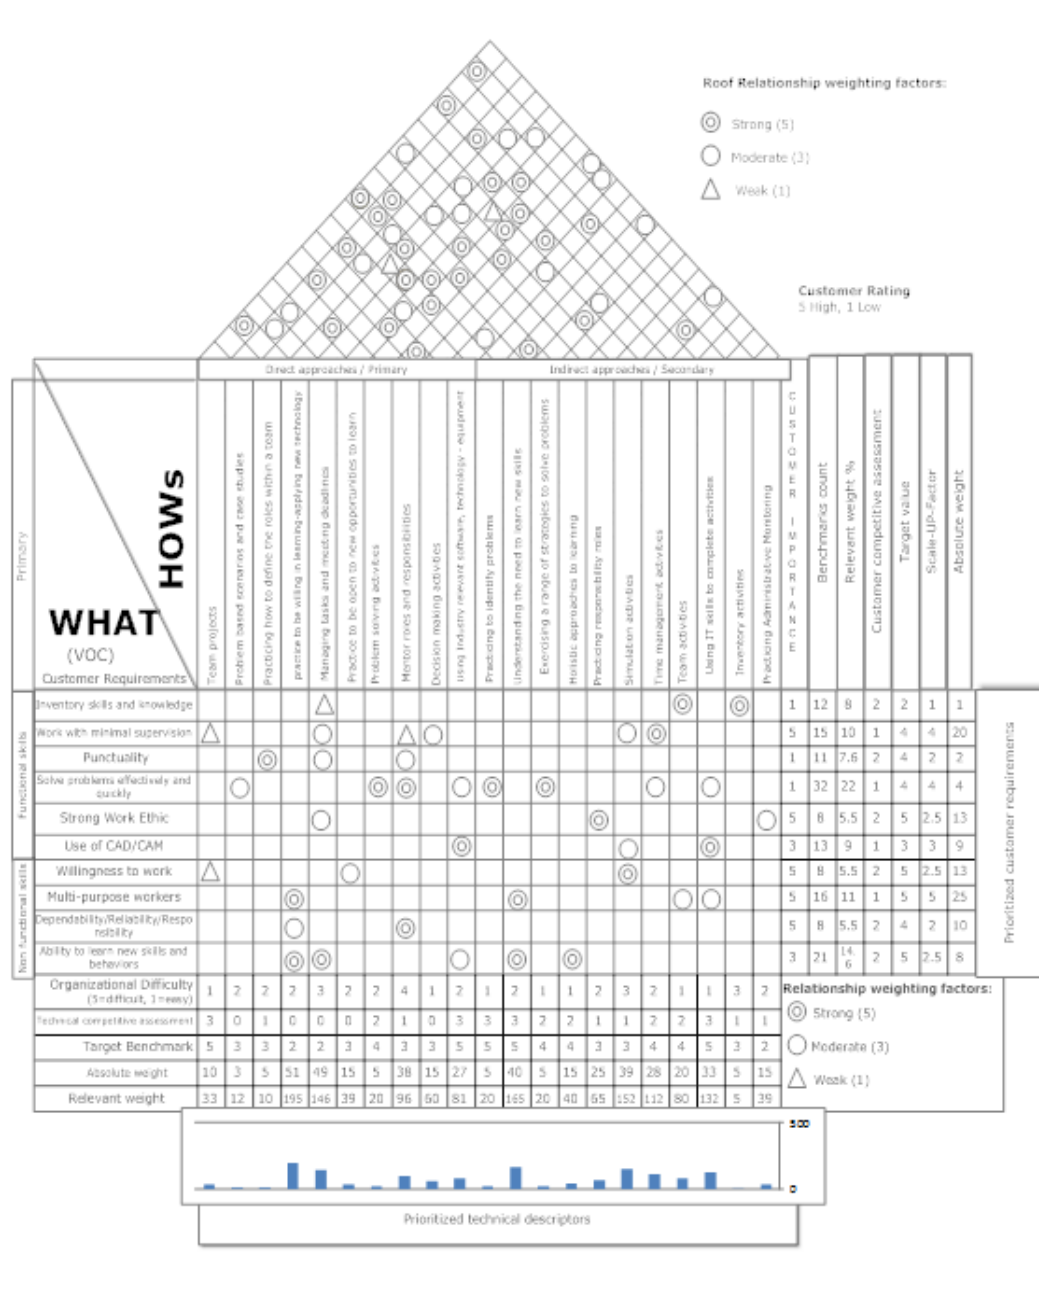
Figure1. “Applied HOQ for top important ten skills of vocational training in